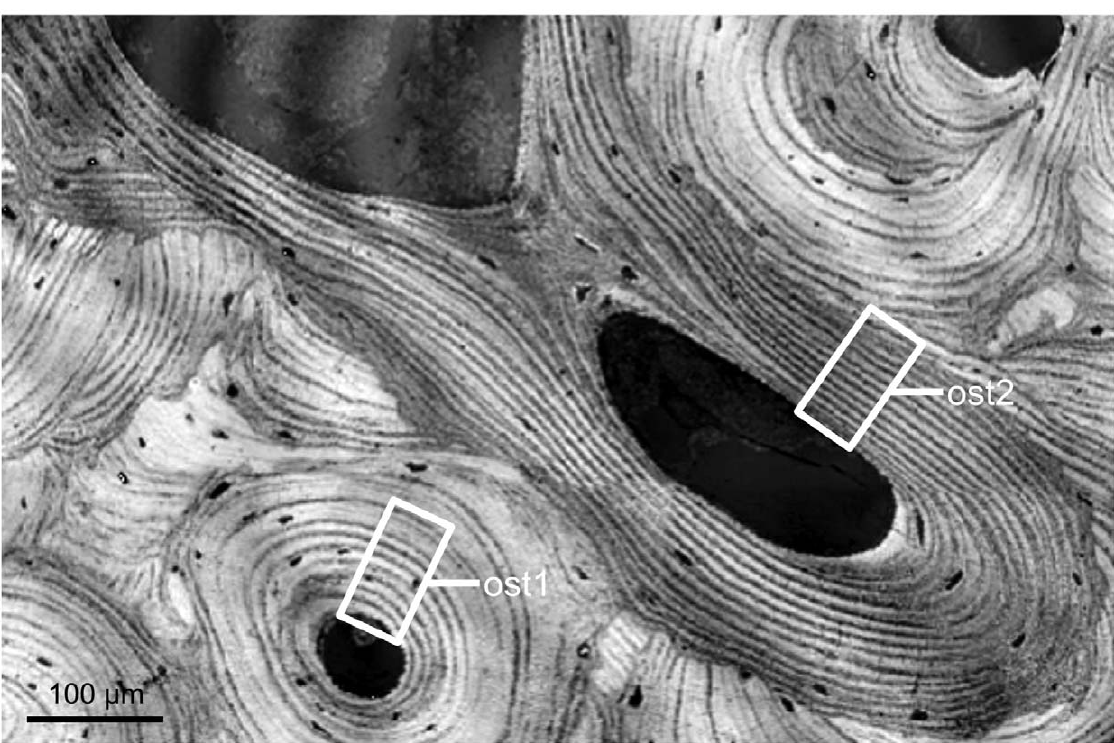
Figure 2. SAM image (amplitude of the reflected ultrasound beam coded in gray levels). The data analysis was performed on an identical site-matched area on each one of the two investigated osteons (namely ost1 and ost2 ).